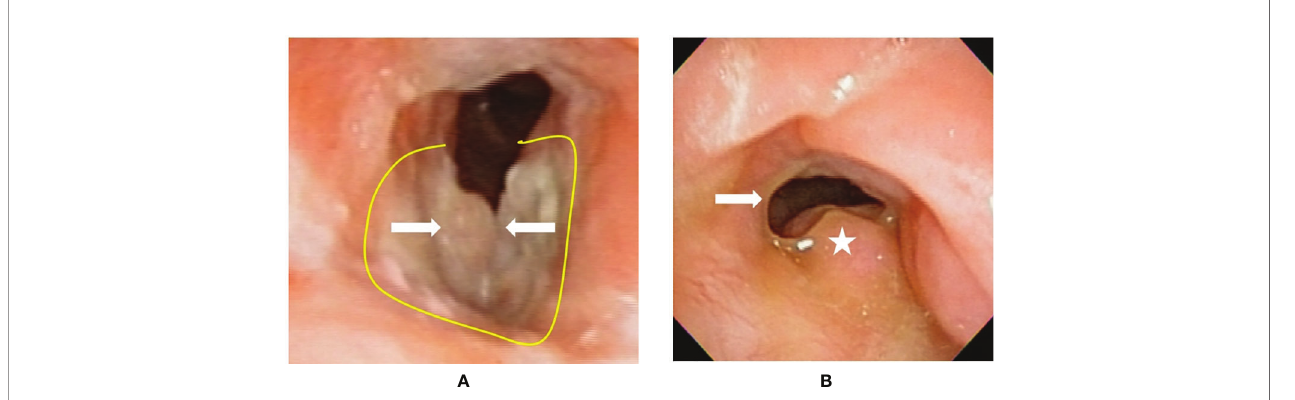
FIGURE 4 | Flexible laryngoscopy view of patient #17 with recurrent cancer (after tran-soral laser microsurgery and radiotherapy failure) before and after transoral robotic surgery (TORS) type VI cordectomy. (A) A cancer (arrow) involving bilateral vocal folds plus anterior commissure. The yellow line revealed the planned incision line surrounding the tumor. (B) After 18 months from TORS without adjuvant radiotherapy, a fi brotic scar (arrow) formed on the right surgical wound bed. The left side false vocal fold had compensatory hypertrophy to maintain sphincter function at the glottis. There was no